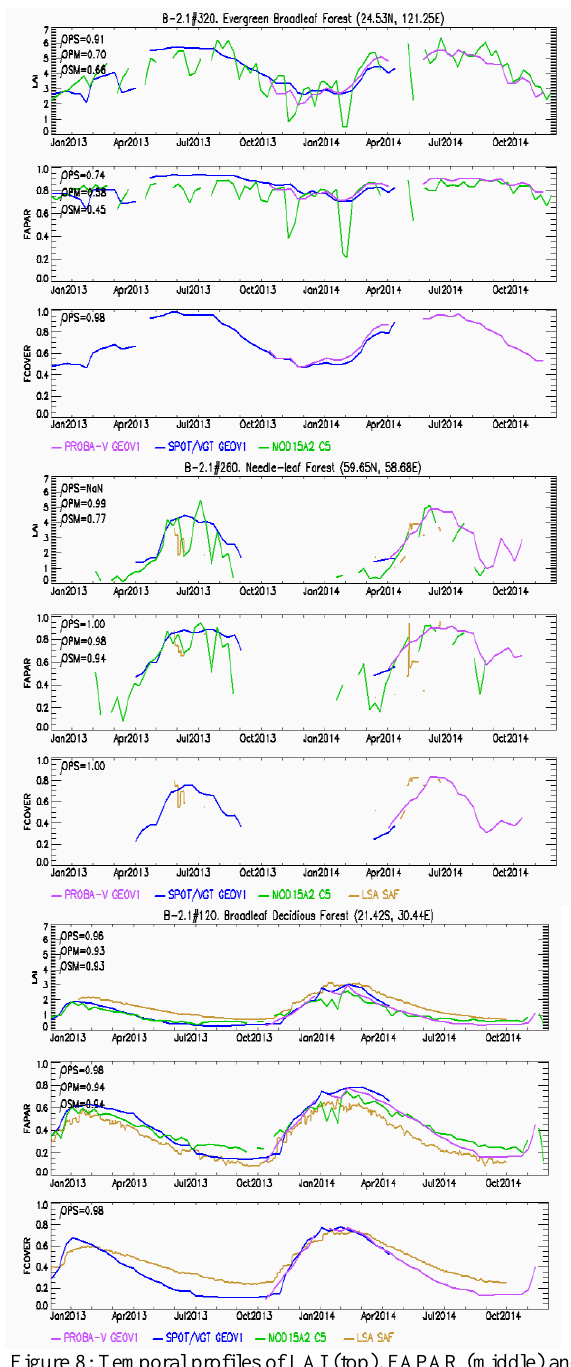
Figure 8: Temporal profiles of LAI (top), FAPAR (middle) and FCover (bottom) values of each product (PROBA-V GEOV1, SPOT/VGT GEOV1, MODIS C5 and LSA SAF) for selected sites of each biome